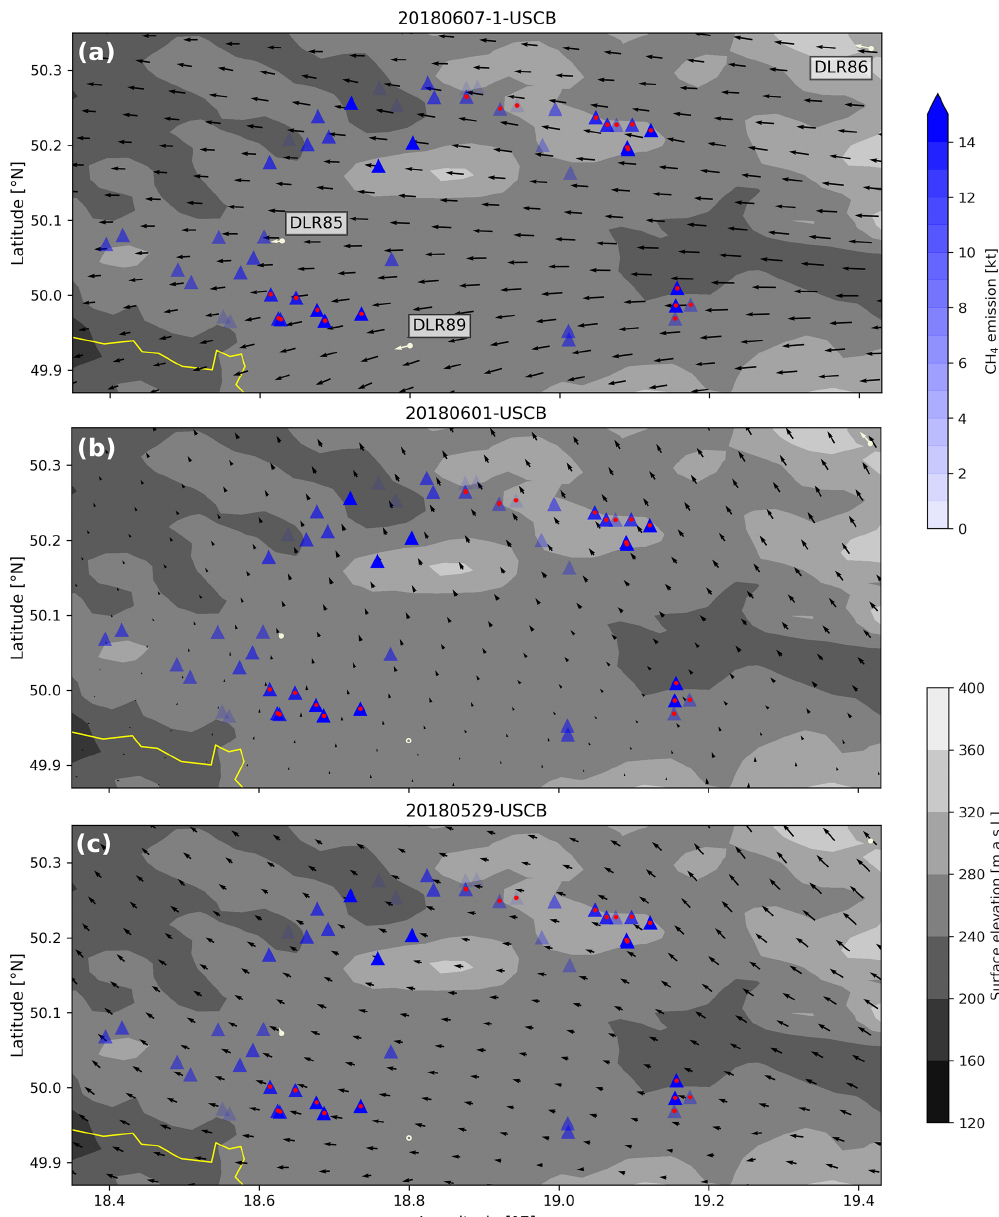
Figure 4. Wind situation in the USCB on three different days. Similar to Fig. 2 but complemented by the PBL averaged 2D wind field from the WRF model simulations (black arrows) and the observed wind at the three lidar stations (white arrows). Panel (a) shows favourable and (b) and (c) less favourable wind conditions on 7 June, 1 June, and 29 May,